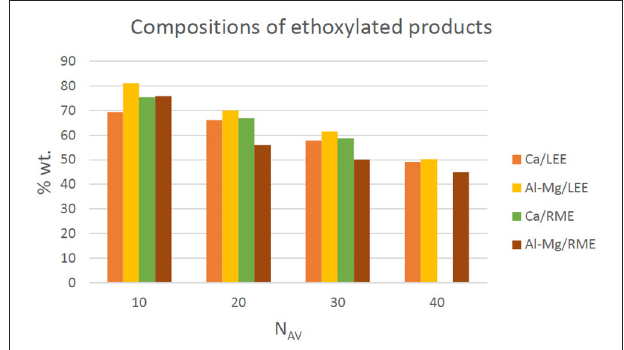
FIGURE 7 | Content of ethoxylated methyl esters (main product—fraction 2) depending on the catalyst used and the hydrophobic raw material.